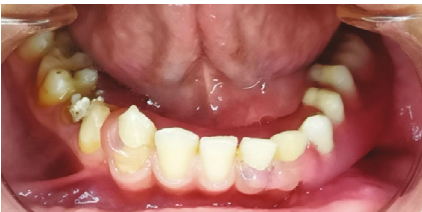
Figure 8: Flexible dentures inside the